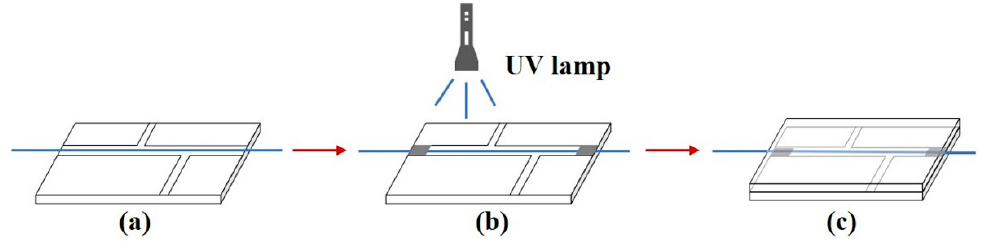
Figure 7. Schematic illustration of encapsulation process: ( a ) embedding the microfiber in the microchannel, ( b ) immobilizing the microfiber by UV photoresist and sealing the horizontal microchannel, and ( c ) adhering another polydimethylsiloxane (PDMS) block onto the first one.